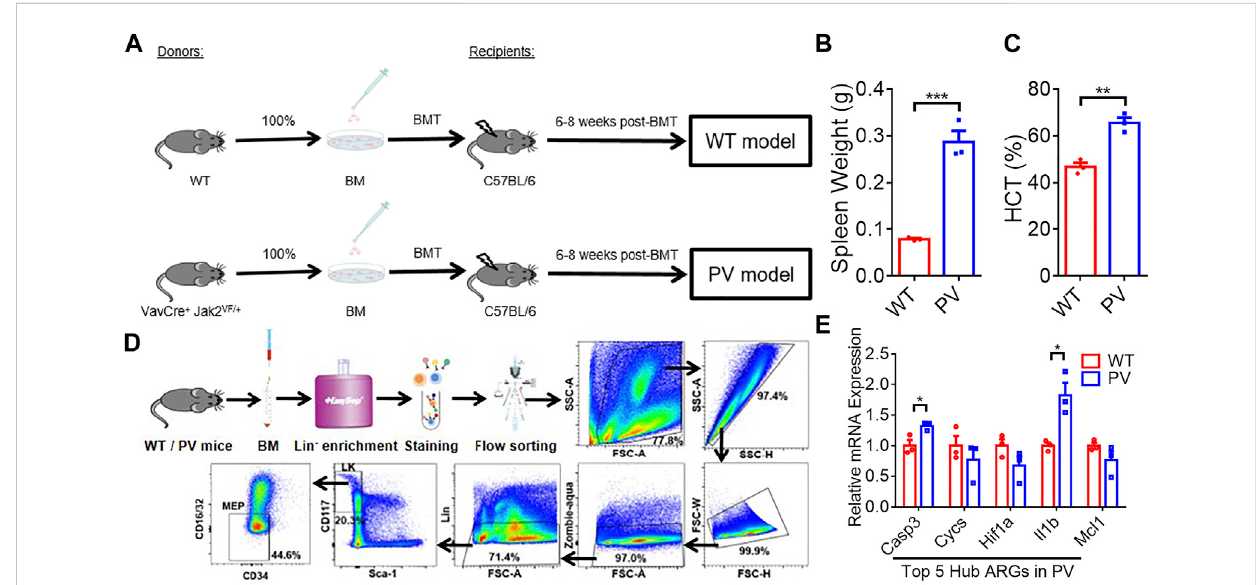
FIGURE 8 The expression difference of PV hub genes in PV mice model. (A) The work fl ow of WT and PV mice model constructed by bone marrow transplantation (BMT). (B) Spleen weight 6 – 8 weeks after BMT. Data are represented as mean ± SEM (*** p < 0.001 versus WT group). (C) Hematocrit (HCT) 6 – 8 weeks after BMT. Data are represented as mean ± SEM (** p < 0.01 versusWT group). (D) The experimental procedure of obtaining WT and PV mice bone marrow megakaryocyte and erythroid progenitors (MEPs) by Lin-cell enrichment and fl ow sorting. (E) The validation of expression difference of fi ve PV hub genes in WT and PV mice